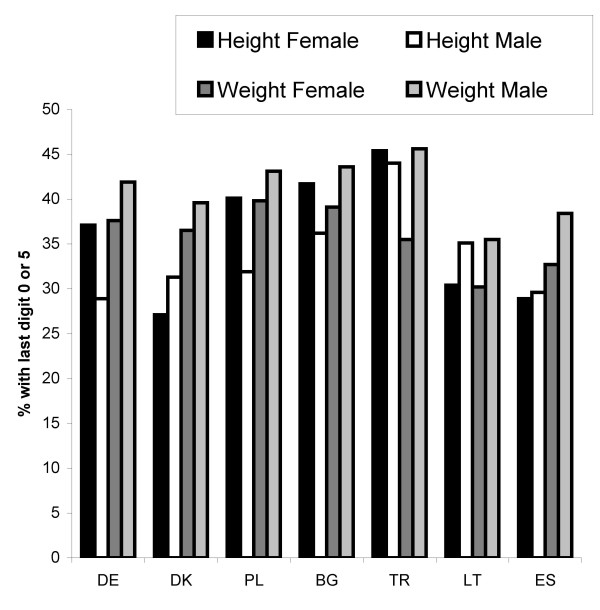
Last digit preference for self-reported weight and height by country and gender. Note: 95% confidence intervals for the proportions are ± 4-5% for female and ± 4-7% for male students in each of the countries.